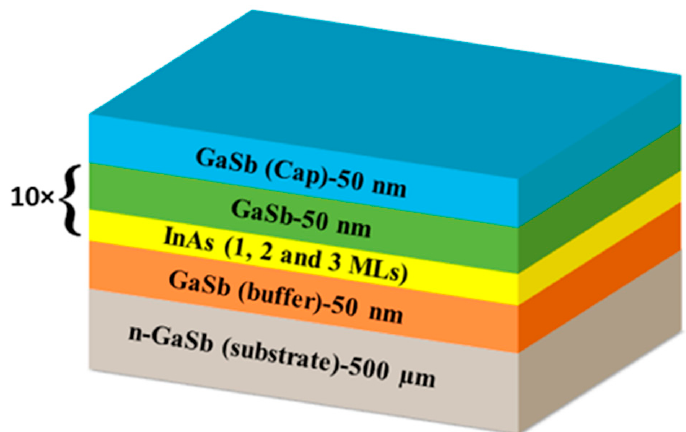
Figure 1. Schematic structure of manufactured InAs/GaSb multi-quantum-wells.